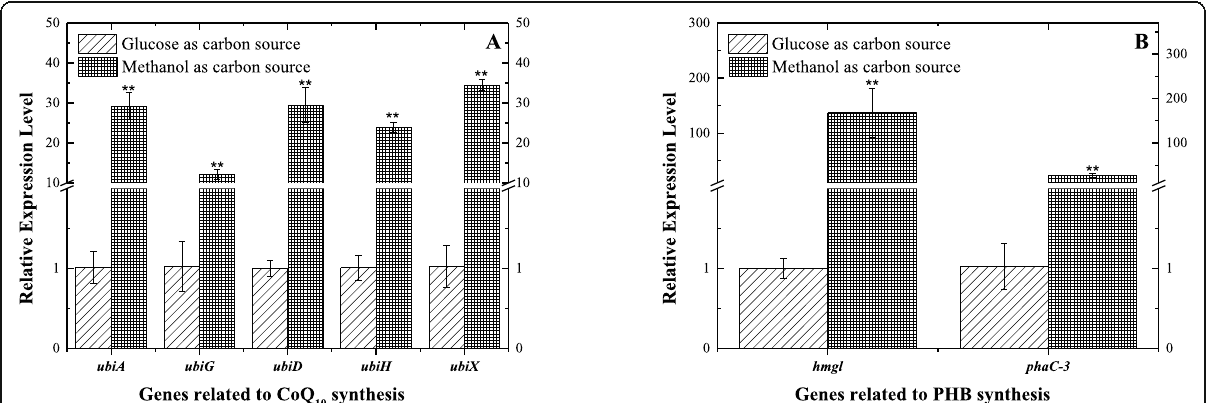
Fig. 4 Effect of carbon source on the express of key genes in CoQ 10 ( a ) and PHB ( b ) biosynthesis pathway via RT-qPCR. Significant differences from glucose group are indicated by * p < 0.05; ** p <